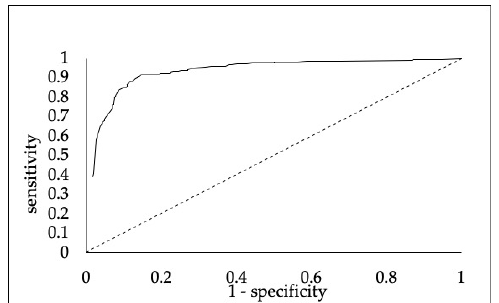
Figure 15. ROC curve results of the defect detection model.